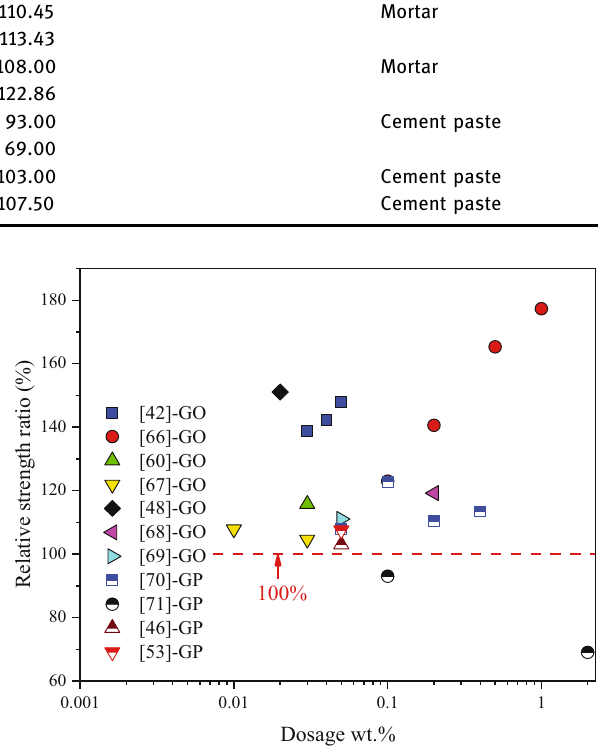
Figure 2: The dosages and the compressive strength e ff